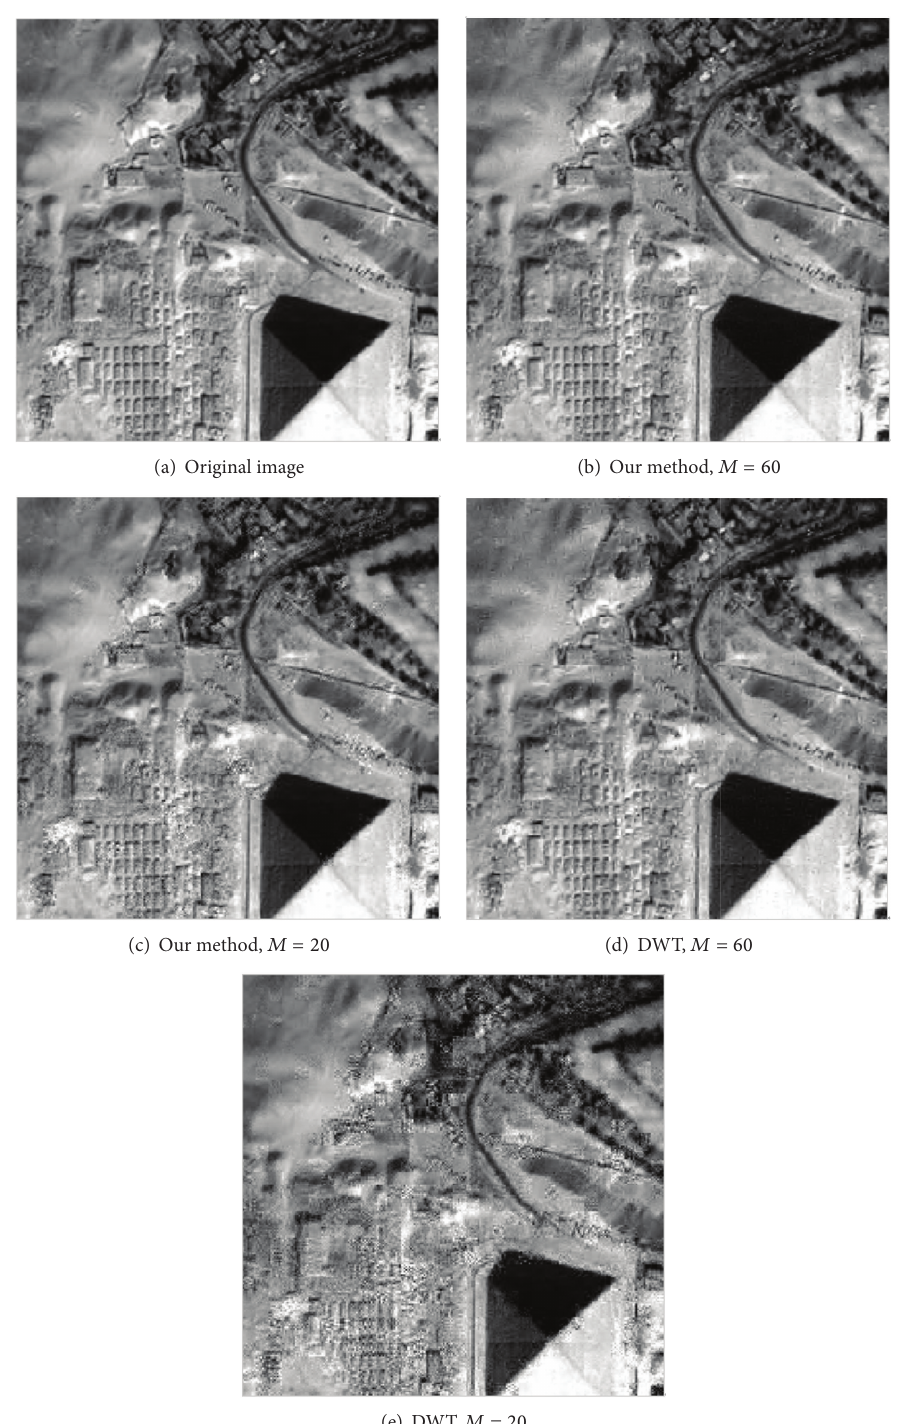
Figure 11: Reconstructed image using our method and DWT as the sparse basis when 𝑀 = 20 and 𝑀 = 40 ; the size of each image is 256×256 .